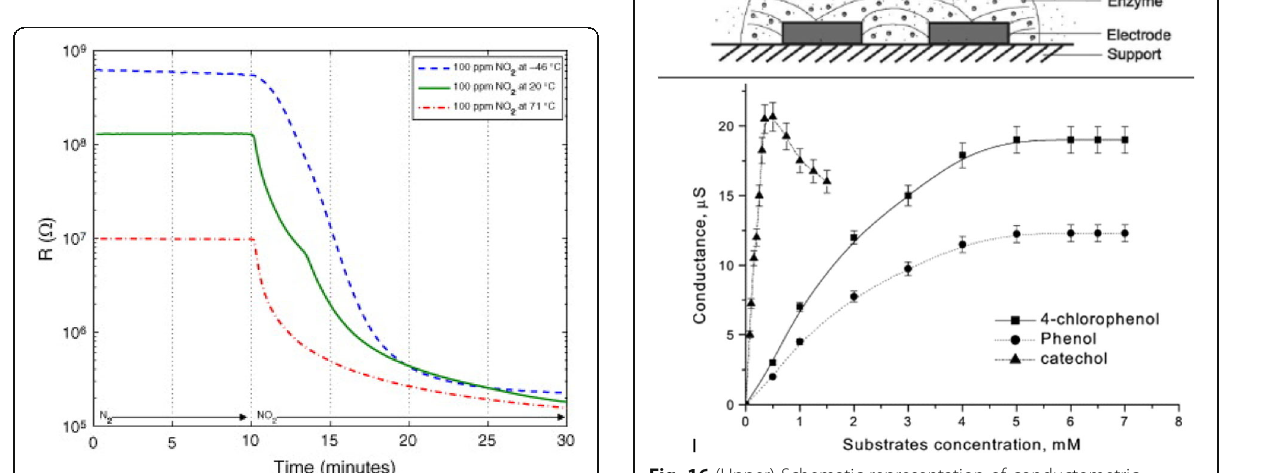
Fig. 16 (Upper) Schematic representation of conductometric biosensor; (below) calibration curves of conductometric tyrosinase biosensor for 4-chlorophenol, phenol, and catechol. (Reprinted with permission from Reference Anh et al. 2004). © 2004